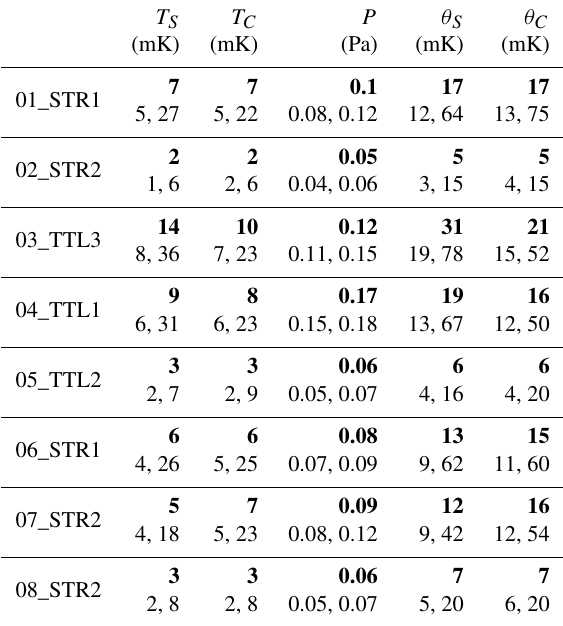
Table 2. Estimated noise (standard deviation) of temperature, pres- sure, and dry potential temperature. For each flight, the first row in- dicates the flight-mean values (bold), and the second row indicates the respective nighttime and daytime average values.